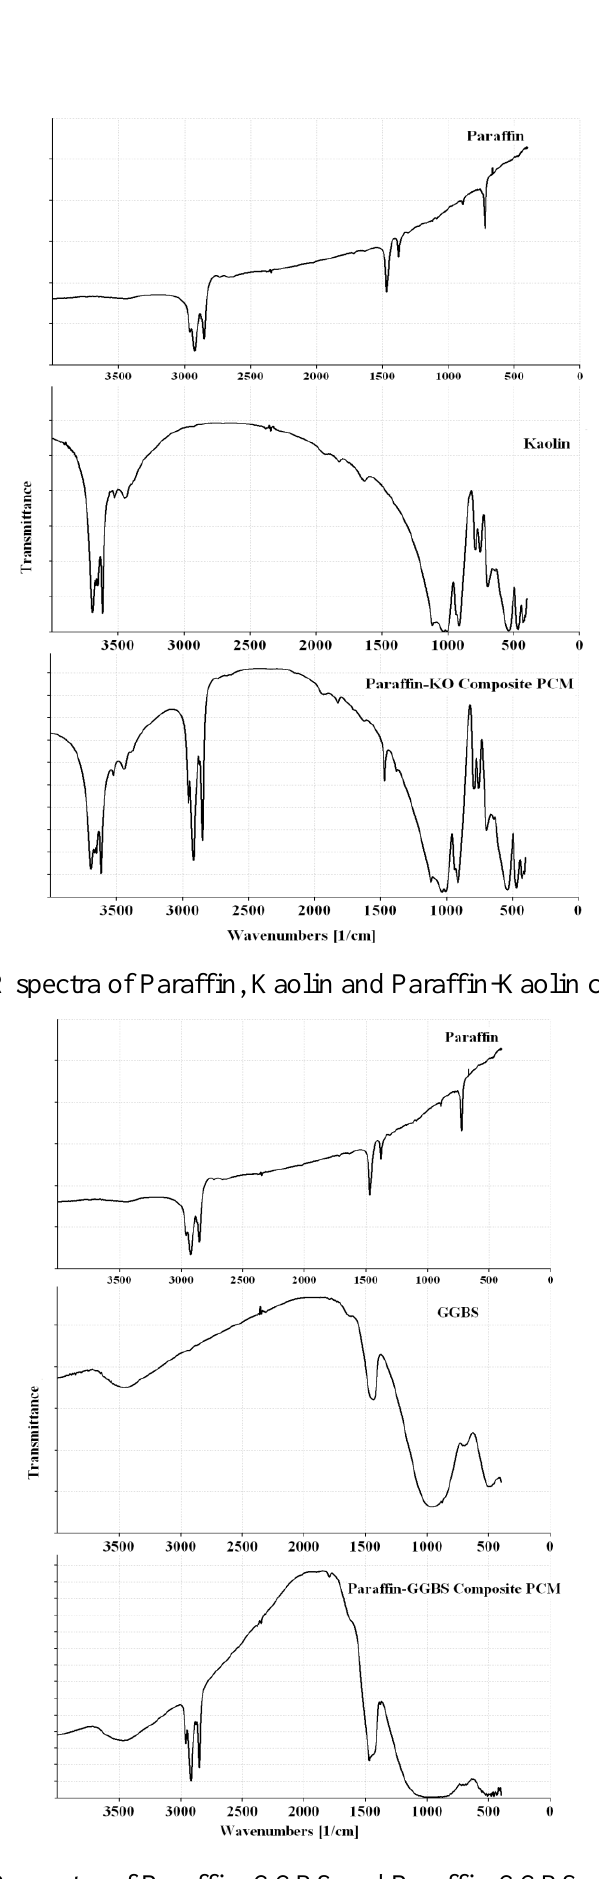
Figure 5. FT-IR spectra of Paraffin, GGBS and Paraffin-GGBS composite